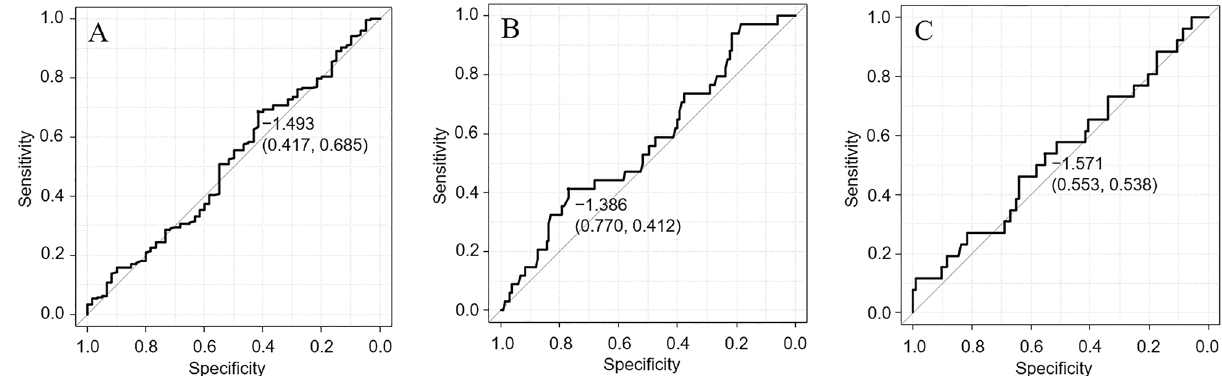
Figure 2. Receiver operating characteristic (ROC) curve of IGF-1 (SD) for the diagnosis of growth hormone deficiency (GHD) for all patients (A), patients aged ≤ 6 years (B), and patients aged > 6 years (C). ROC analysis for all patients showed the best diagnostic accuracy at an IGF-1 cutoff of − 1.493 standard deviation (sensitivity, 0.685; specificity, 0.417; and area under the ROC curve, 0.517).